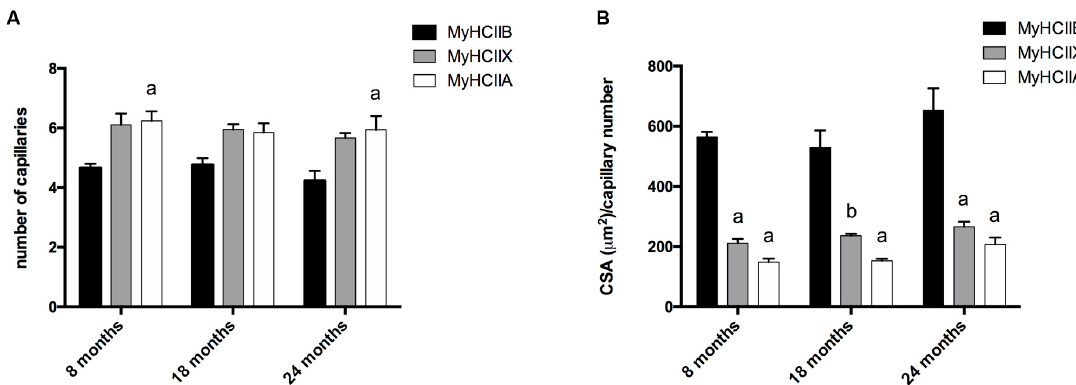
Figure 4. Analysis of fiber-type-dependent capillarization. ( A ) The capillary number depends on the fiber type (a, significantly different from age-matched type-IIB fibers, p < 0.05). ( B ) The analysis of the ratio between CSA and capillaries number indicates differences depending on fiber type (a, significantly different from age-matched type-IIB fibers, p < 0.0001; b, significantly different from age-matched type-IIB fibers, p < 0.001). Data are reported as means ± SEM.